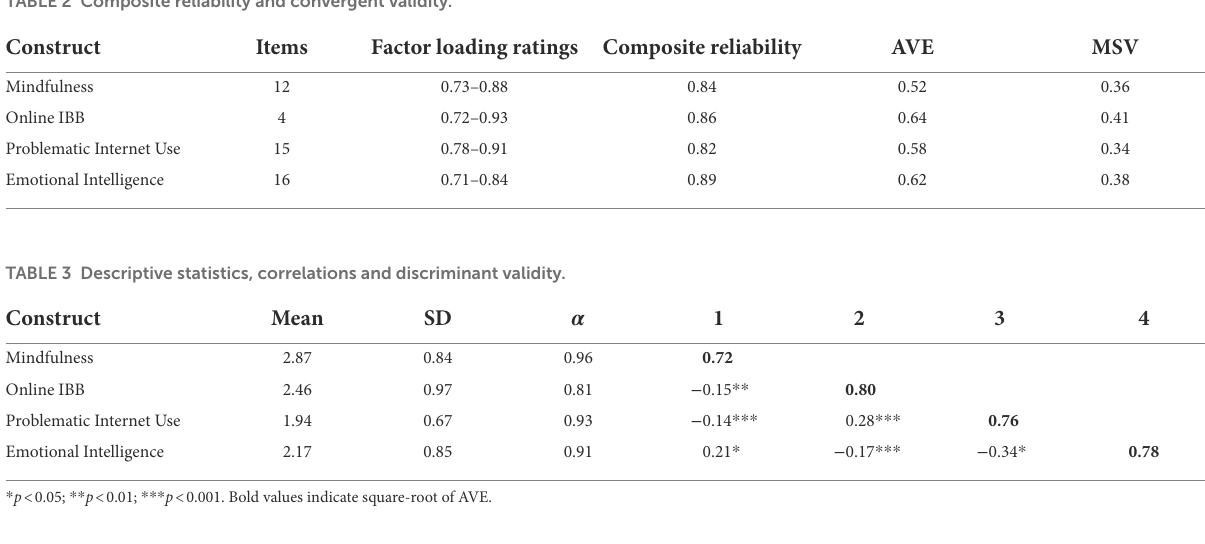
TABLE 2 Composite reliability and convergent validity.